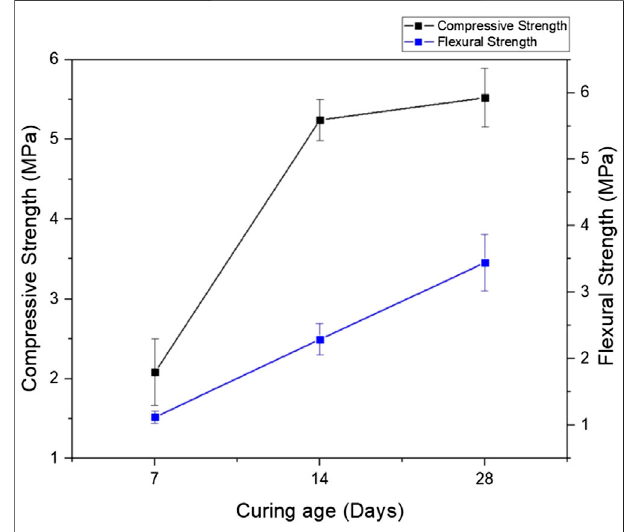
FIGURE 7 | Mechanical performance of the prepared foamed alkali- activated glass with different curing